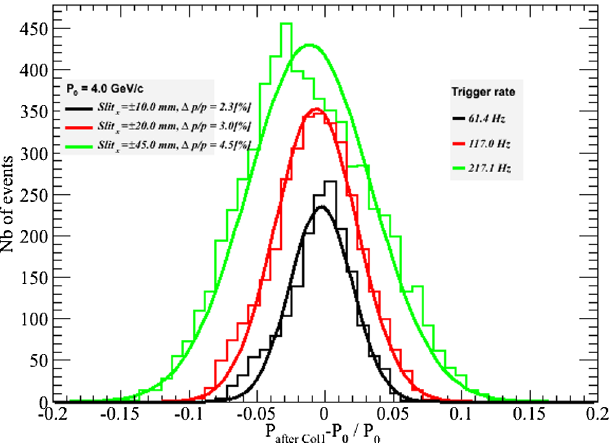
FIG. 12. Momentum bite of the beam for three different collimator slit sizes, for the case of 4 GeV =c beam. The full- acceptance momentum spread is